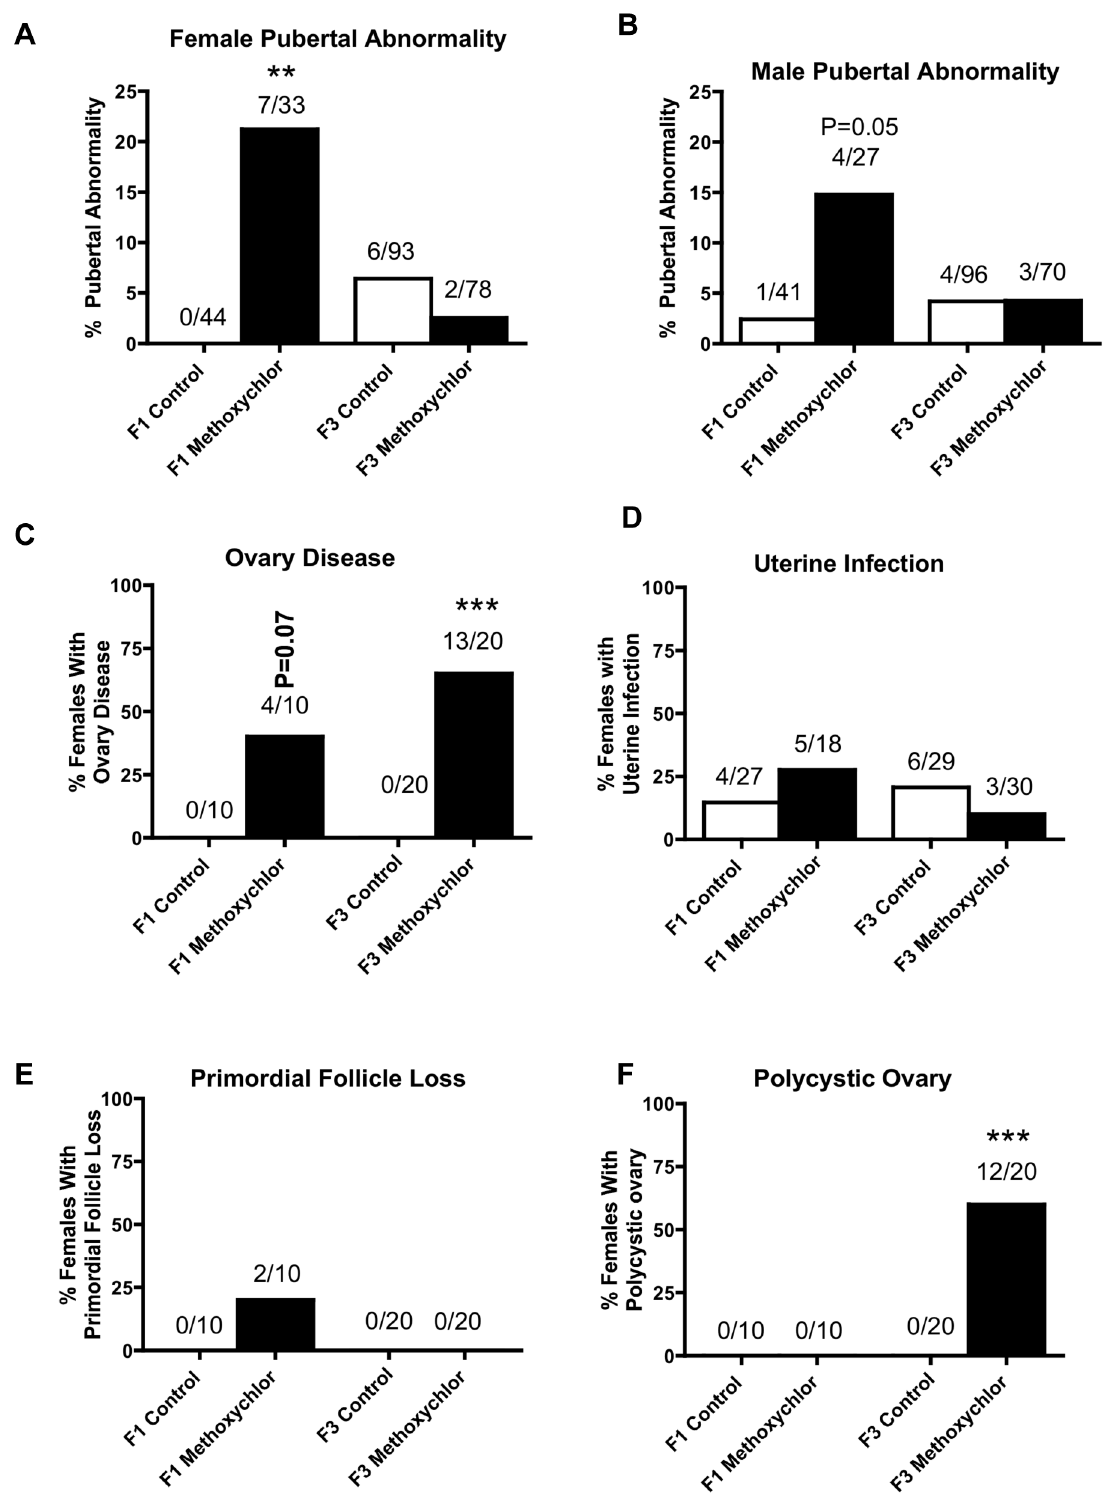
Figure 2. Ancestral exposure to methoxychlor and transgenerational pubertal abnormalities, and ovarian and uterine diseases. Percentages of females F1 and F3 generation (panel A) and males (panel B) with pubertal abnormality or females with ovarian disease (panel C) or uterine infection (panel D). Percentages of the F1 and F3 generation females with primordial follicle loss (panel E) and polycystic ovary disease (panel F) in control and methoxychlor lineages. The number of diseased rats / total number of rats in each lineage are also shown. (** P , 0.01; *** P , 0.001).